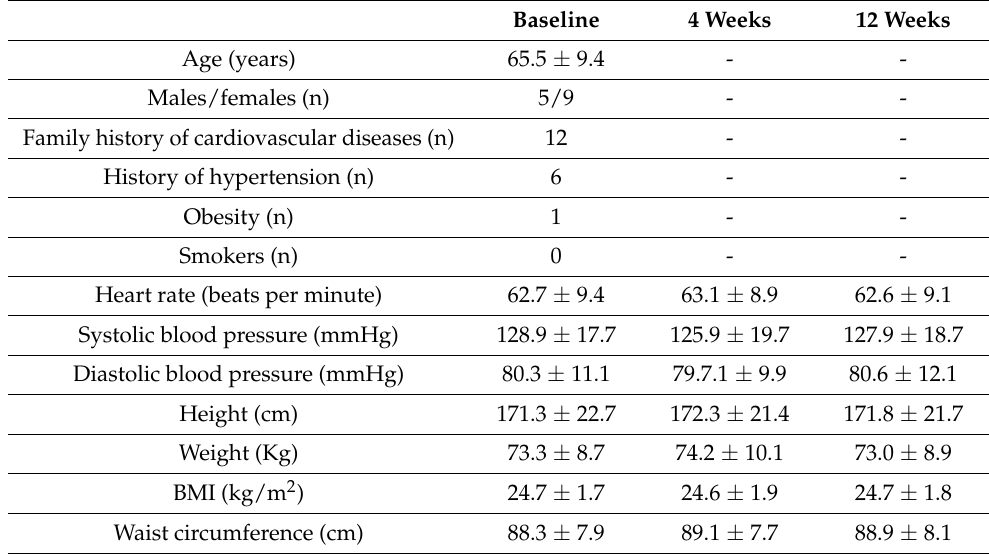
Table 2. Clinical and anthropometric characteristics of the study population at baseline, and after four and 12 weeks. Baseline 4 Weeks 12 Weeks Age (years) 65.5 ± 9.4 - - Males/females (n) 5/9 - - Family history of cardiovascular diseases (n) 12 - - History of hypertension (n) 6 - - Obesity (n) 1 - - Smokers (n) 0 - - Heart rate (beats per minute) 62.7 ± 9.4 63.1 ± 8.9 Systolic blood pressure (mmHg) Diastolic blood pressure (mmHg) 80.3 ± 11.1 Height (cm) 171.3 ± 22.7 172.3 ± 21.4 171.8 ± 21.7 Weight (Kg) 73.3 ± 8.7 BMI (kg/m 2 ) Waist circumference (cm) 89.1 ± 7.7 88.9 ±